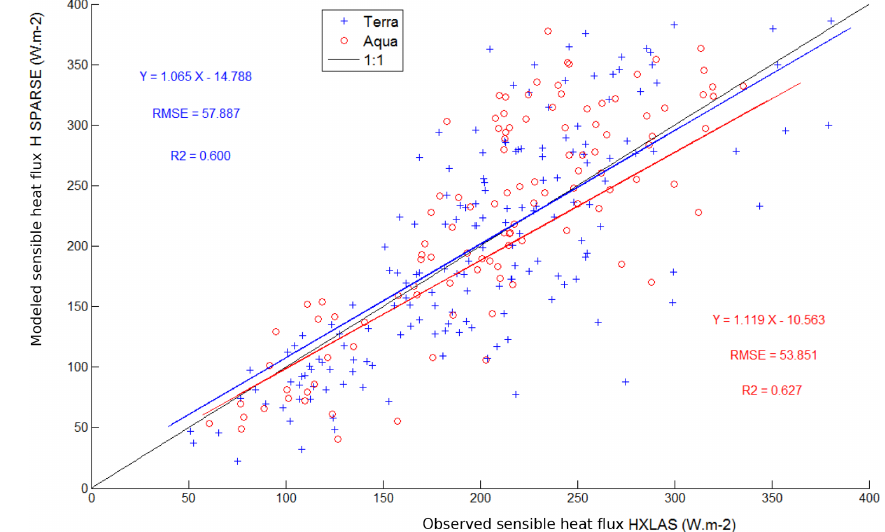
Figure 7. Modeled vs. observed sensible heat fluxes at Terra and Aqua overpass times.